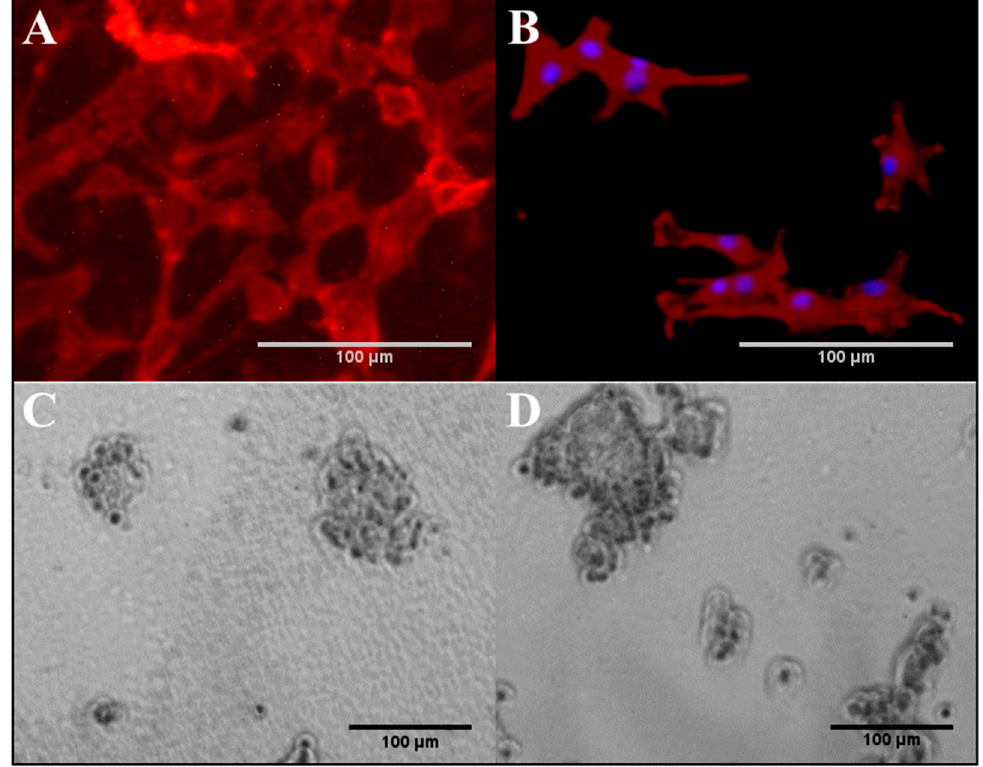
Figure 8. Attachment and growth of cells on p(HEMA- co- HMMA- co -PEGMA) hydrogels. NIH/3T3 cells on ( A ) non-conductive, base (0.0 wt% PAn-PAAMPSA) and ( B ) electroconductive (0.1 wt% PAn-PAAMPSA). PC-12 cells on non-conductive, base (0.0 wt% PAn-PAAMPSA) with ( C ) 200 µg/mL collagen and ( D ) 500 µg/mL collagen.